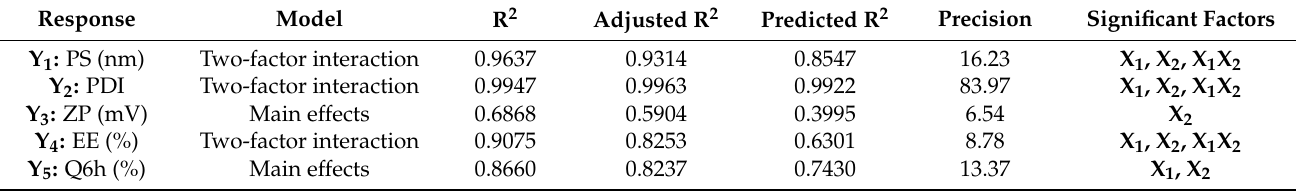
Table 3. Regression analysis of the observed responses according to the best fitting